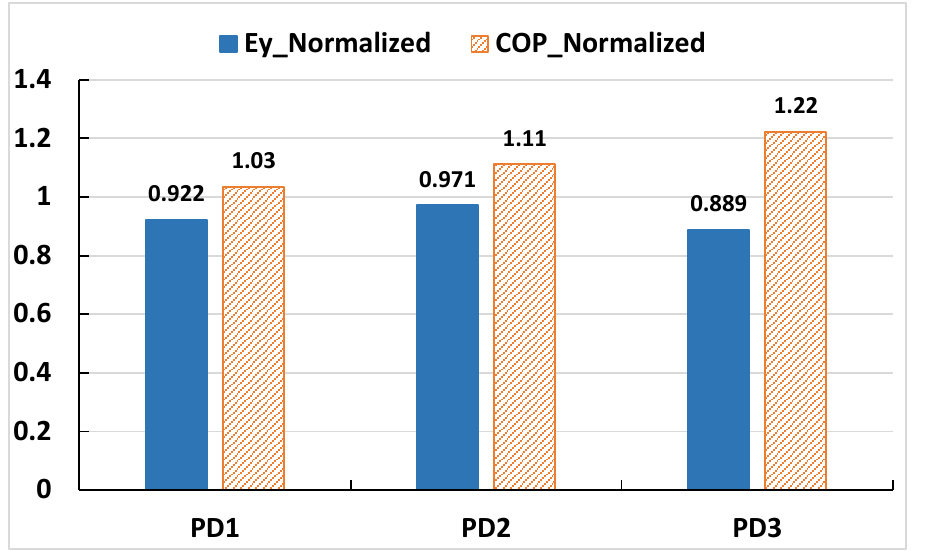
. Figure 15. Values of 〈𝐸̇ 𝑦 〉 𝑡 and COP normalized with respect to values of case B1 (ΔT = 4.27 K) for E y (cid:105) t and COP normalized with respect to values of case B1 ( ∆ T = 4.27 K) for Figure 15. Values of (cid:104) various length combinations. various length